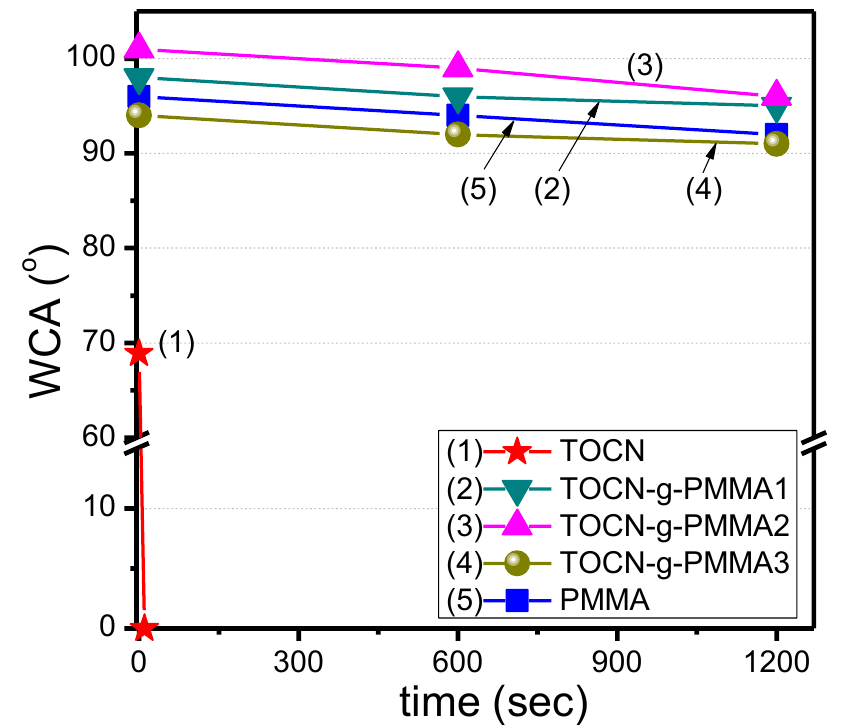
Figure 6. Contact angle measurements of ( 1 ) TEMPO-oxidized cellulose nanofibers (TOCN), ( 2–4 ) TOCN – g – PMMAs with different grafting molecular weight (MW) (listed in Table 2), and ( 5 ) pure PMMA.